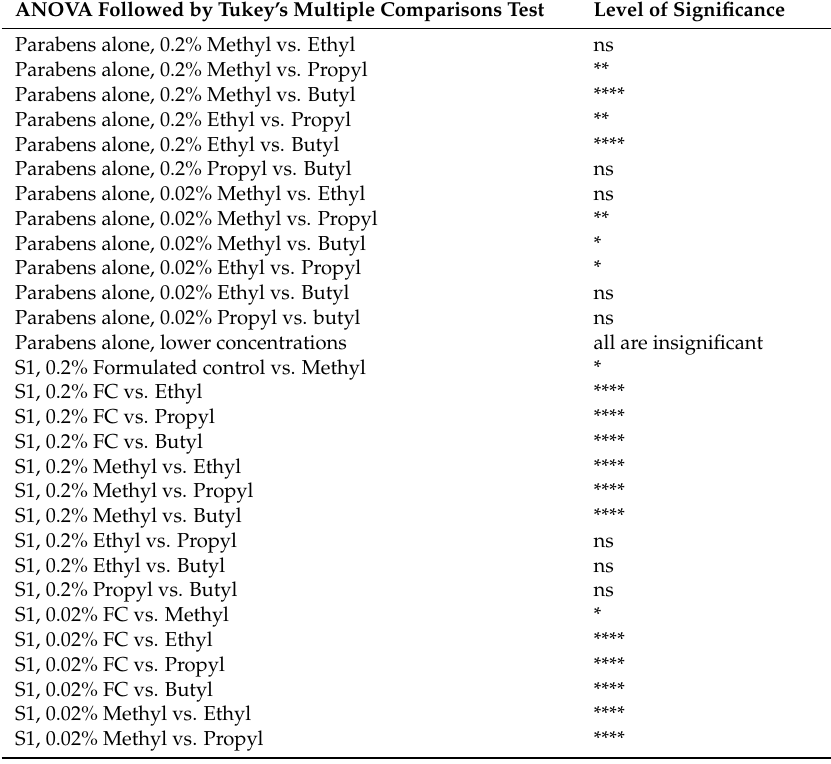
Table 3. Result of Tukey's multiple comparison test performed on the results of Caco-2 cells. FC: formulated control, Methyl: formulated methyl-paraben, Ethyl: formulated ethyl-paraben, Propyl: formulated propyl-paraben, Butyl: formulated butyl-paraben. * p < 0.05; ** p < 0.01; *** p <